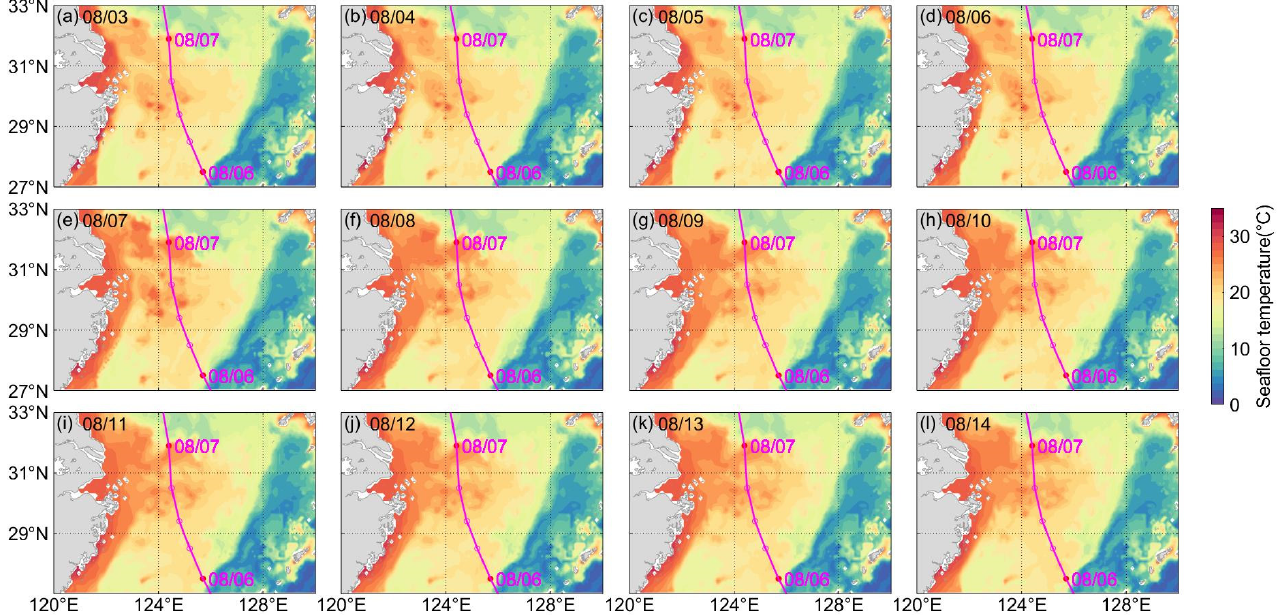
Figure 4. SST at 00:00 on ( a ) 3, ( b ) 4, ( c ) 5, ( d ) 6, ( e ) 7, ( f ) 8, ( g ) 9,( h ) 10, ( i ) 11, ( j ) 12, ( k ) 13 and ( l ) 14 August.